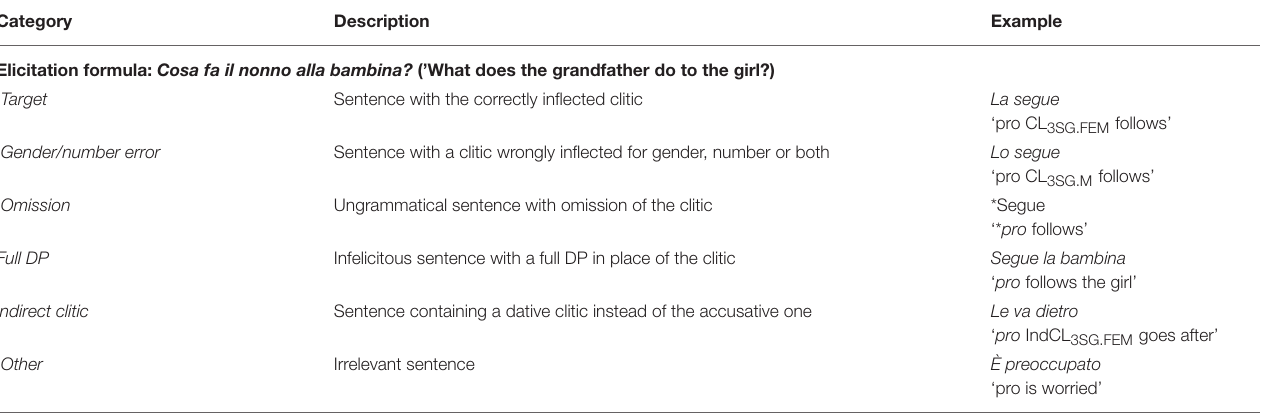
TABLE 2 | Response coding for the clitic task in the Simple Present.